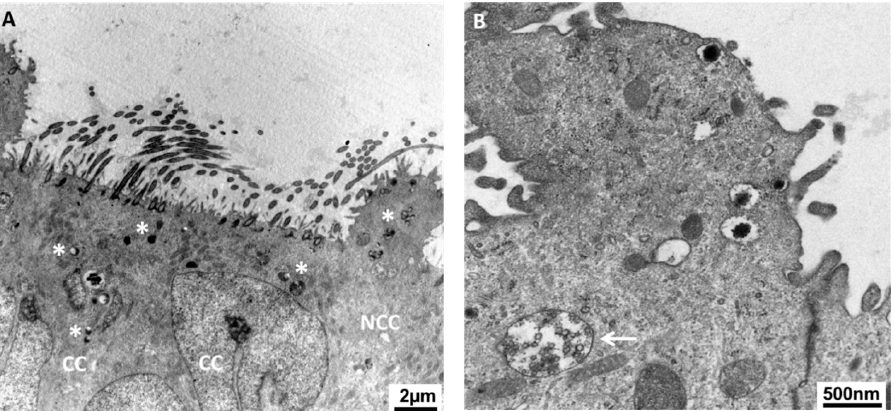
Figure 3. Both non-ciliated and ciliated cells are likely to participate in oviductal secretions. Transmission electronic microscopy reveals many secretory granules in both types of cells ( A ) as well as multivesicular bodies (MVB, B ) close to the apical lumen of porcine oviduct epithelium. Asterisks indicate the secretory granules. The arrow points at the MVB. NCC: non-ciliated (secretory) cell; CC: ciliated cell.